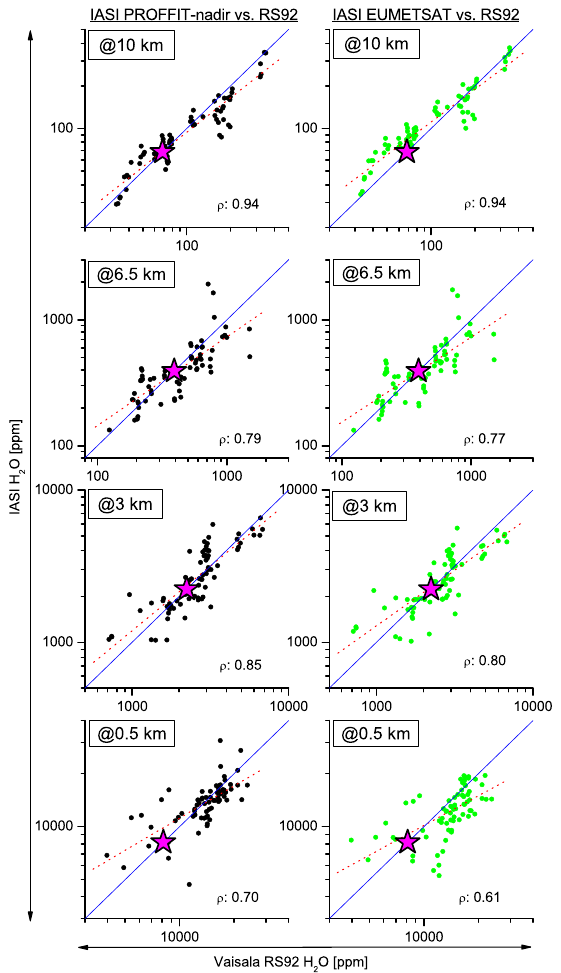
Fig. 8. Correlation plots between IASI and Vaisala RS92 H 2 O data. From the bottom to the top for 0 . 5 , 3 , 6 . 5 , and 10 km altitude. Left panels for IASI PROFFIT-nadir and right panels for IASI EUMET- SAT products. The magenta stars, the red dotted line, and the blue solid line, indicate the applied a priori values, the linear regression line, and the diagonal ( x = y ) line, respectively.